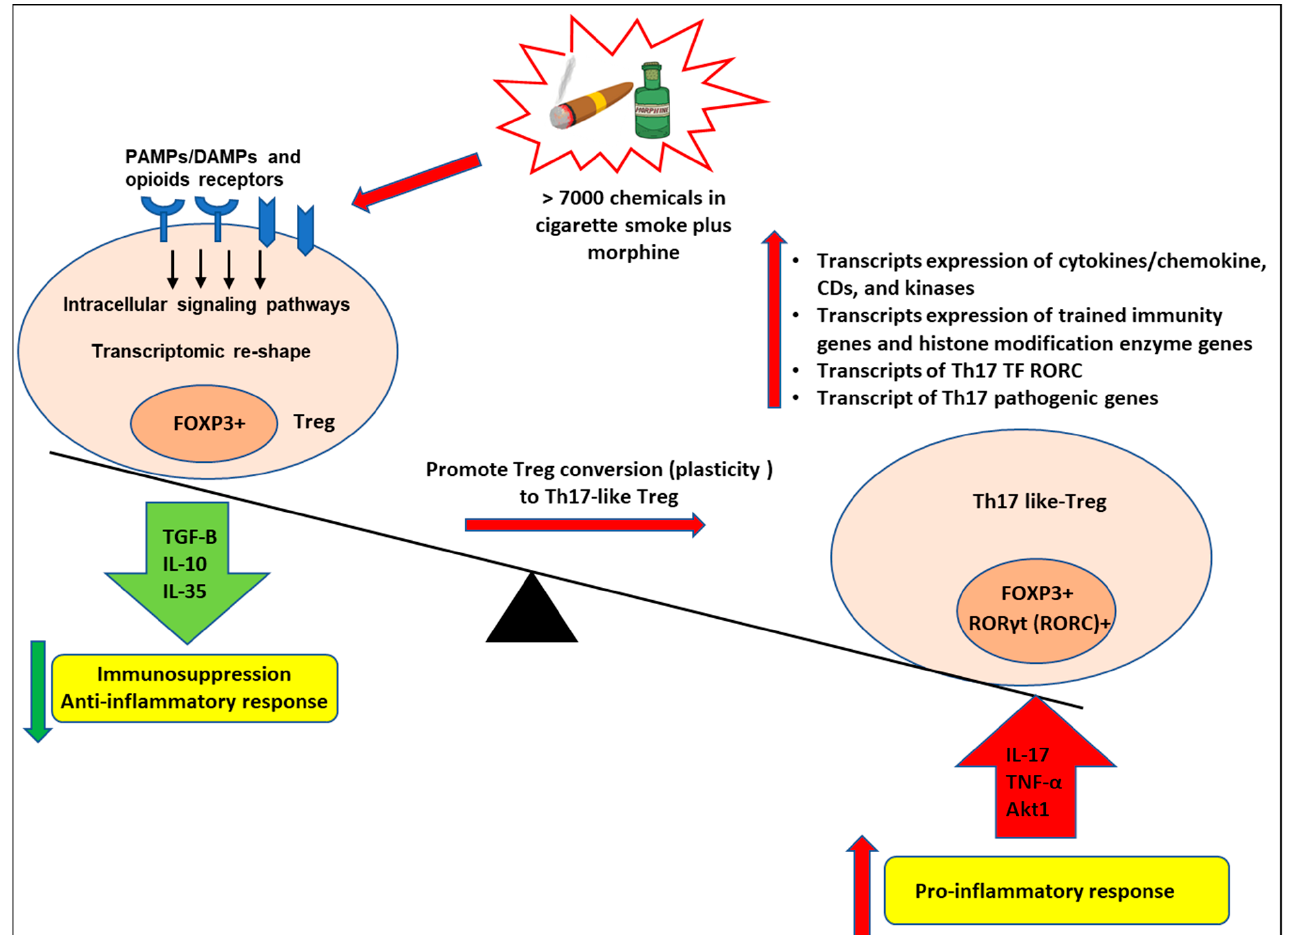
Figure 9. Our working model. More than 7000 chemicals in cigarette smoke and morphine bind to the membrane and intracellular PAMPs/DAMPs and opioid receptors in the FOXP3+ Tregs and induce intracellular signaling pathways and Tregs transcriptomic reshaping. Tregs can be induced by smoke plus morphine to become proinflammatory cells expressing RORC, which lose suppressive capacity while retaining FOXP3 expression. In the presence of smoke plus morphine, Tregs can acquire a Th17-like phenotype. These cells will increase the transcript expression of Th17 transcription factor RORC, which promotes Tregs conversion (plasticity) to Th17-like cells and increases the transcript expression of cytokines and their interactors, chemokines, CDs, kinases, and phosphatases. Furthermore, cigarette smoke plus morphine-treated Tregs will increase the transcript expression of trained immunity genes and histone modification enzyme genes, resulting in a decreased immunosuppression function of Tregs and enhanced immune inflammatory response and leading to increased trained immunity as underlying mechanisms contributing to Tregs plasticity to Th17-like